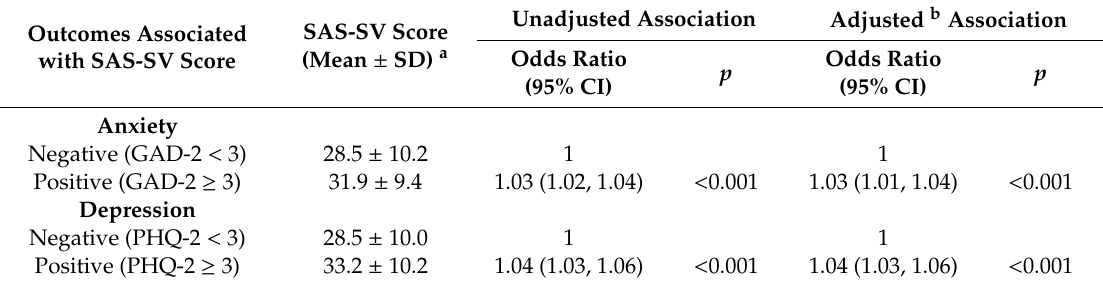
Table 2. Odds of anxiety and depression associated with SAS-SV score ( N =